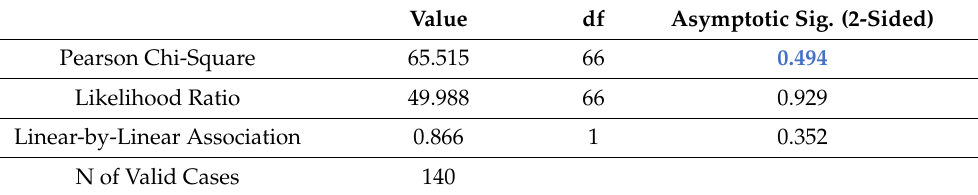
Table 18. The results for Chi-Square bivariate test.